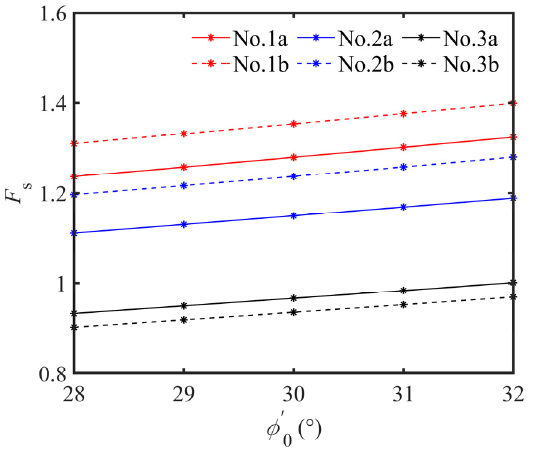
Figure 10. Relationship between the safe factor of local stability and friction angle of